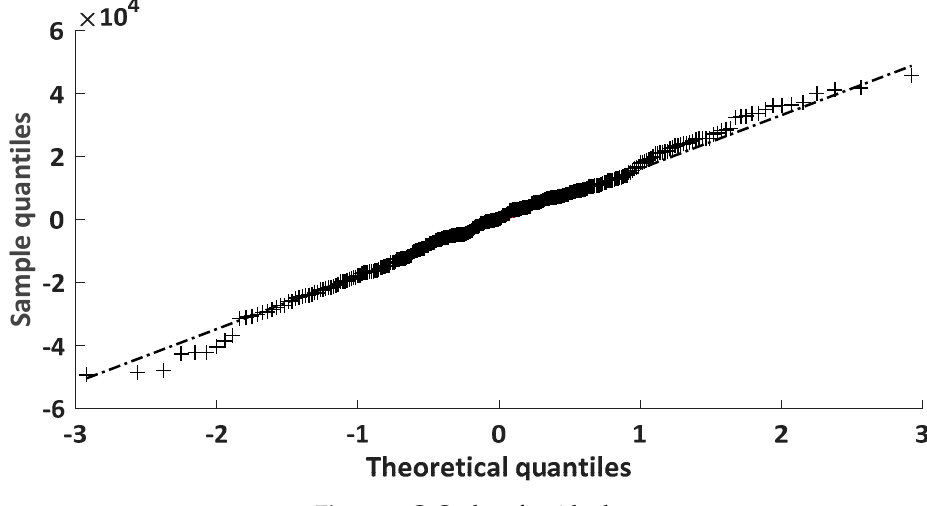
Figure 7. Q-Q plot of residuals.